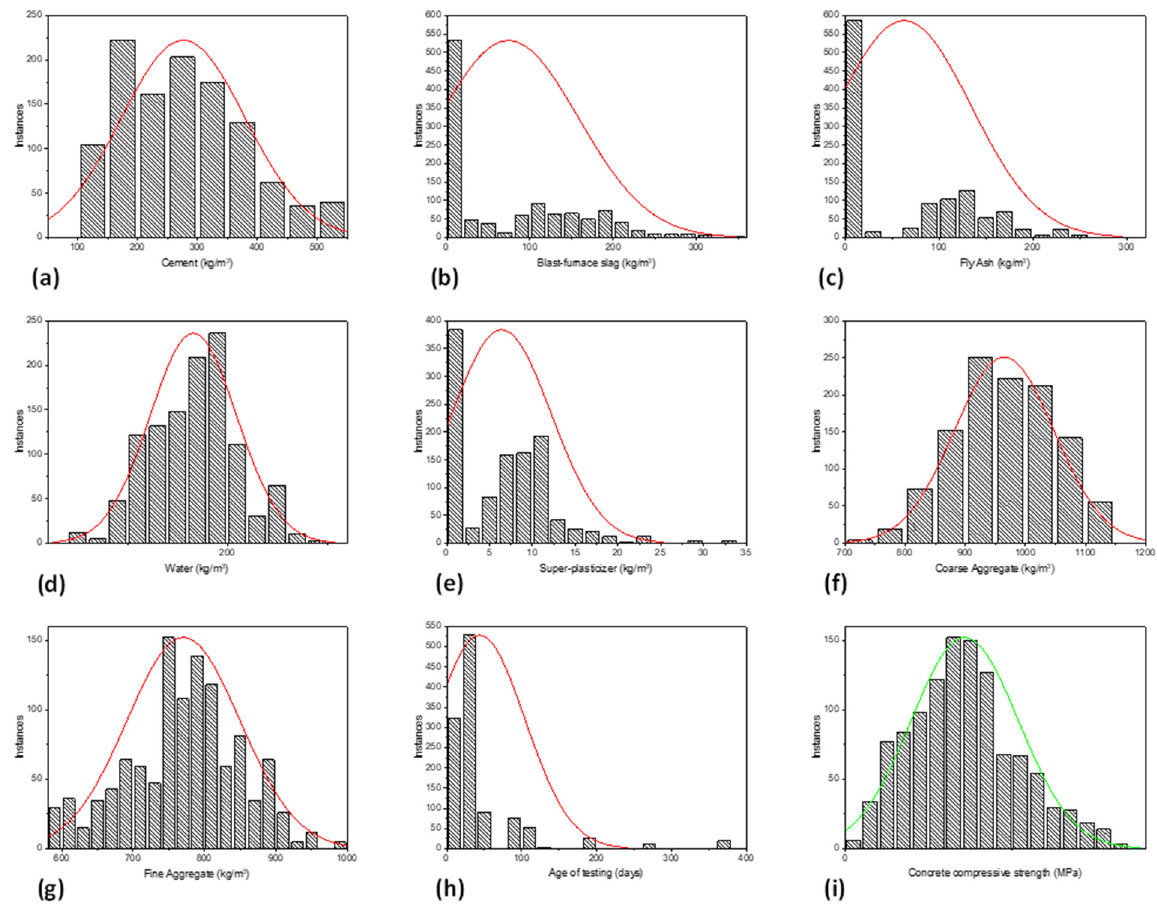
Figure 1. Distribution histogram of varaibles. ( a ) Cement, ( b ) Blast furnace slag, ( c ) Fly Ash, ( d ) water, ( e ) superplasticizer, ( f ) Coarse Aggregates, ( g ) Fina Aggregates, ( h ) Age of testing, ( i ) Concrete compressive strength; Red line shows normal distribution curve for inputs; Green line denotes normal distribution curve for the output variable.